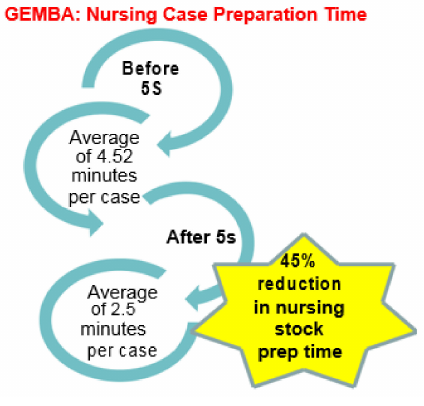
Figure 5. Virtual Gemba